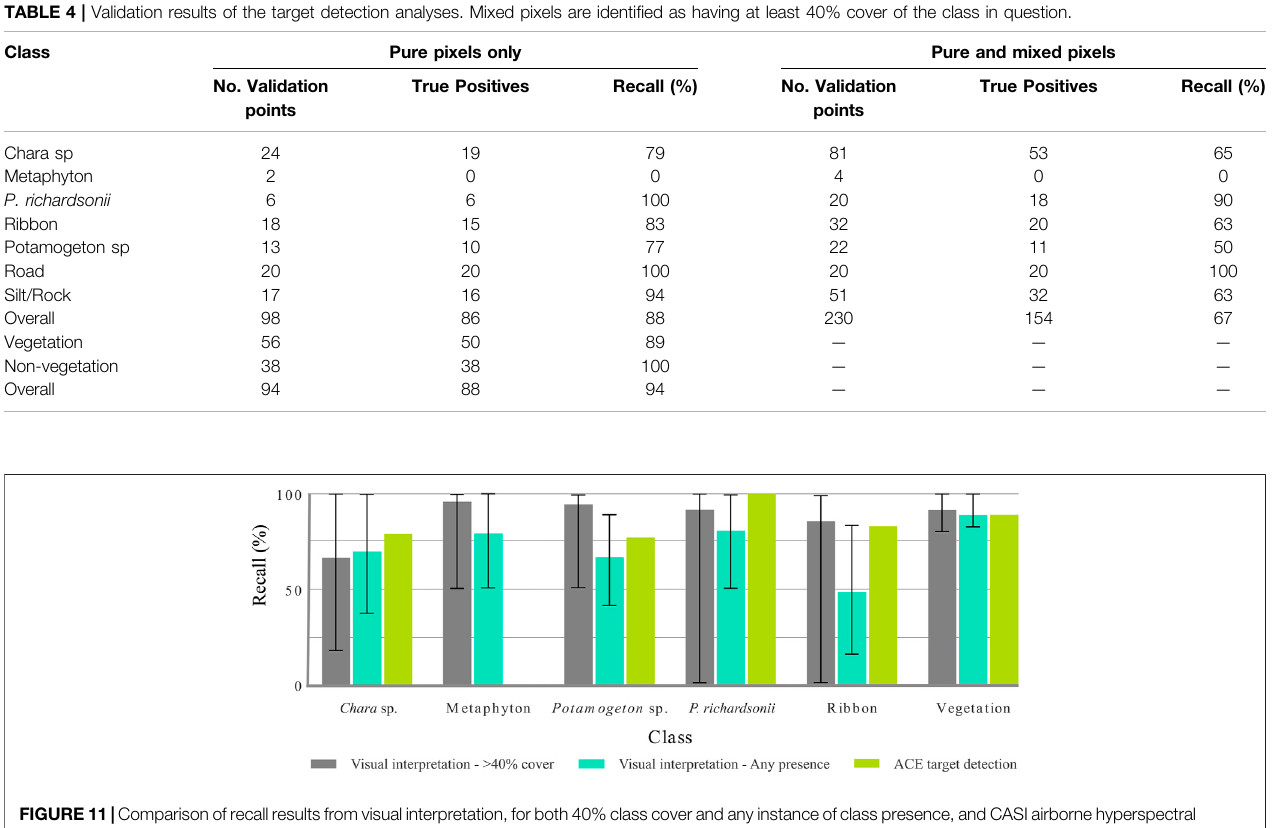
Frontiers in Environmental Science |